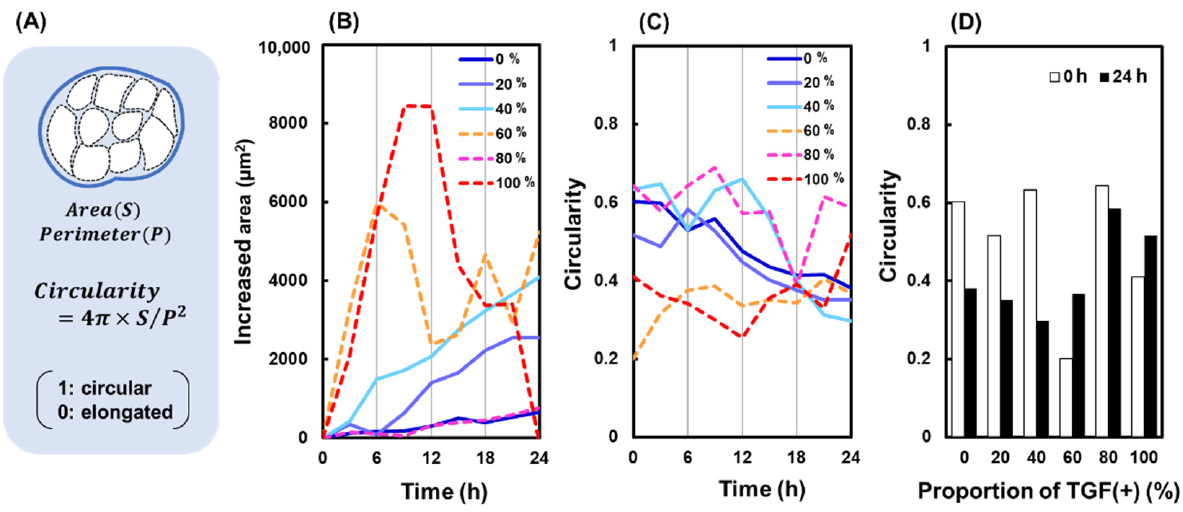
Figure 2. Changes in colony shape. ( A ) Definition of circularity. ( B ) Area at different TGF (N) and time. ( C ) Circularity changes over different times. ( D ) Circularity at 0 and 24 h with different TGF (N). In Figure 3, TGF (0) and TGF (100) did not move as colonies, as their endpoints returned to their original state. TGF (20) moved along the fiber, showing only slight changes in the direction of movement. TGF (80) also moved approximately the same distance but in repeated forward and backward directions. The centers of mass of TGF (40) and TGF (60) moved similar distances.